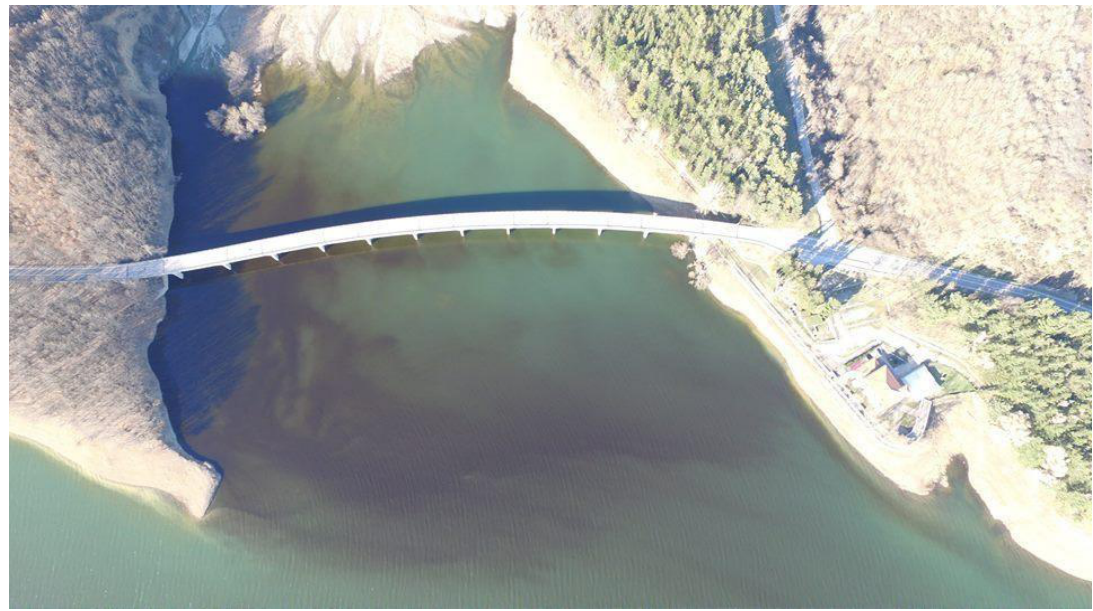
Figure 4. Pollution reported by local newspapers, state road 598 bridge in the center north of Lake Pertusillo and Masseria Crisci sampling site N 40.28977 E 15.95180, on 27 February 2017 (drone image by Michele Tropiano).